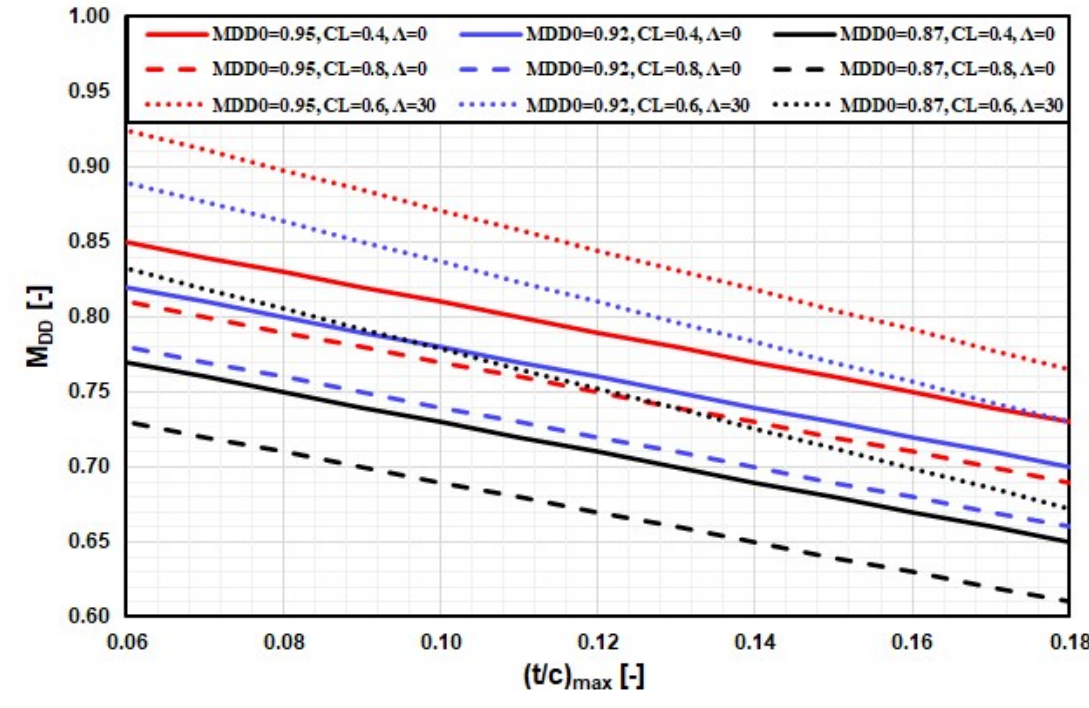
Figure 2. Drag-divergence Mach as a function of wing-technology factor, wing’s maximum relative- thickness, coefficient-of-lift, and sweep-angle using modified Korn’s equation.